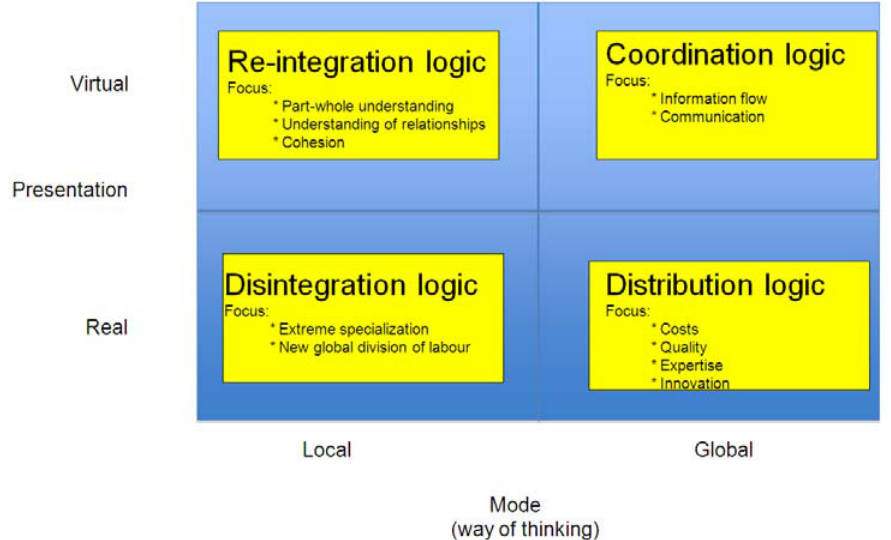
Fig. 2. Modular flexibility in the global knowledge economy – a